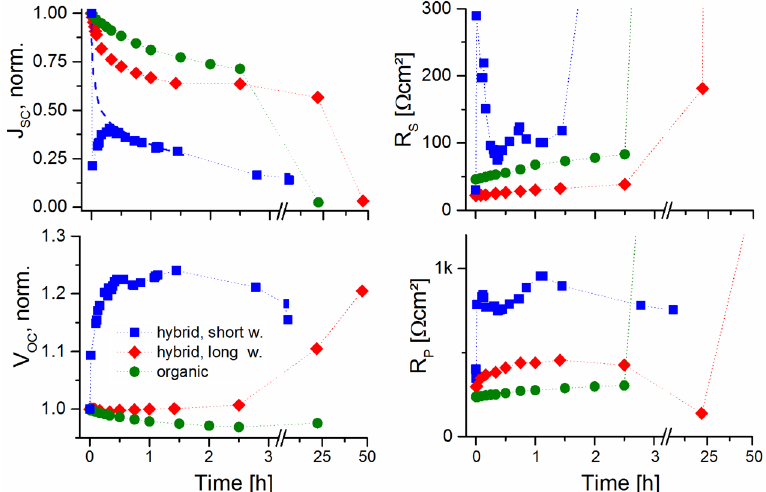
Figure 10. Development by time of short circuit current densities, series resistances, open circuit voltages, and parallel resistances for hybrid BHJ CdSe/PCPDTBT solar cells with short-time HA washed and long-time HA washed NCs, and for an organic BHJ PC 61 BM/PCPDTBT solar cell for comparison when taken into air. Since the J SC of the solar cell containing short washed QDs displayed a fast initial decrease from its original value, an extrapolated graph has been added to guide the eye.